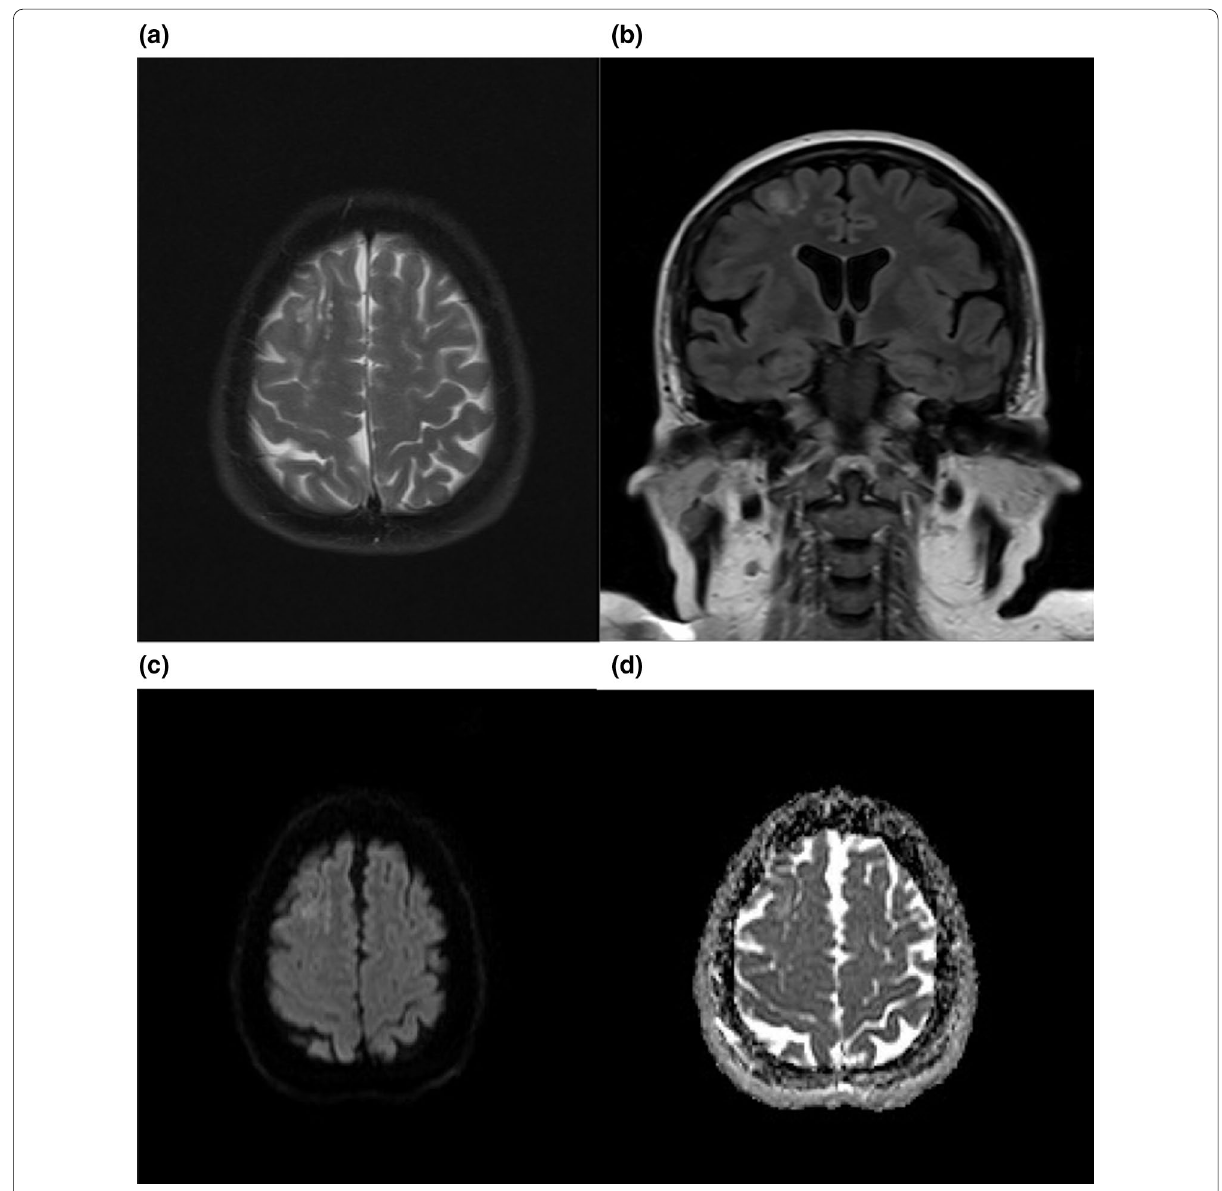
Fig. 2 Axial T2 ( a ) and coronal FLAIR ( b ) images reveal clustered hyperintense lesions in superficial white matter of right frontal lobe. Also, no diffusion restriction was observed ( c , d